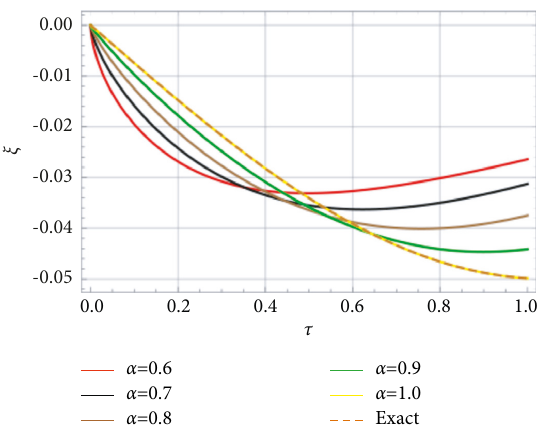
Figure 6: The approximate and exact solutions to the imaginary part of Example 3.